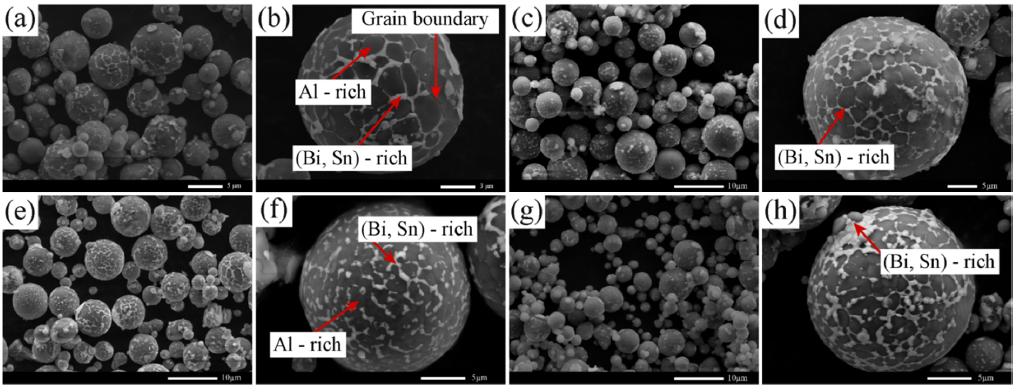
Figure 3. SEM images of the as-atomized Al–Bi–Sn–Cu composite powders: (a–b) Al–10Bi–7Sn, (c–d) Al–10Bi–7Sn–0.5Cu, (e–f) Al–10Bi–7Sn–1.5Cu, (g–h) Al–10Bi–7Sn–3Cu.